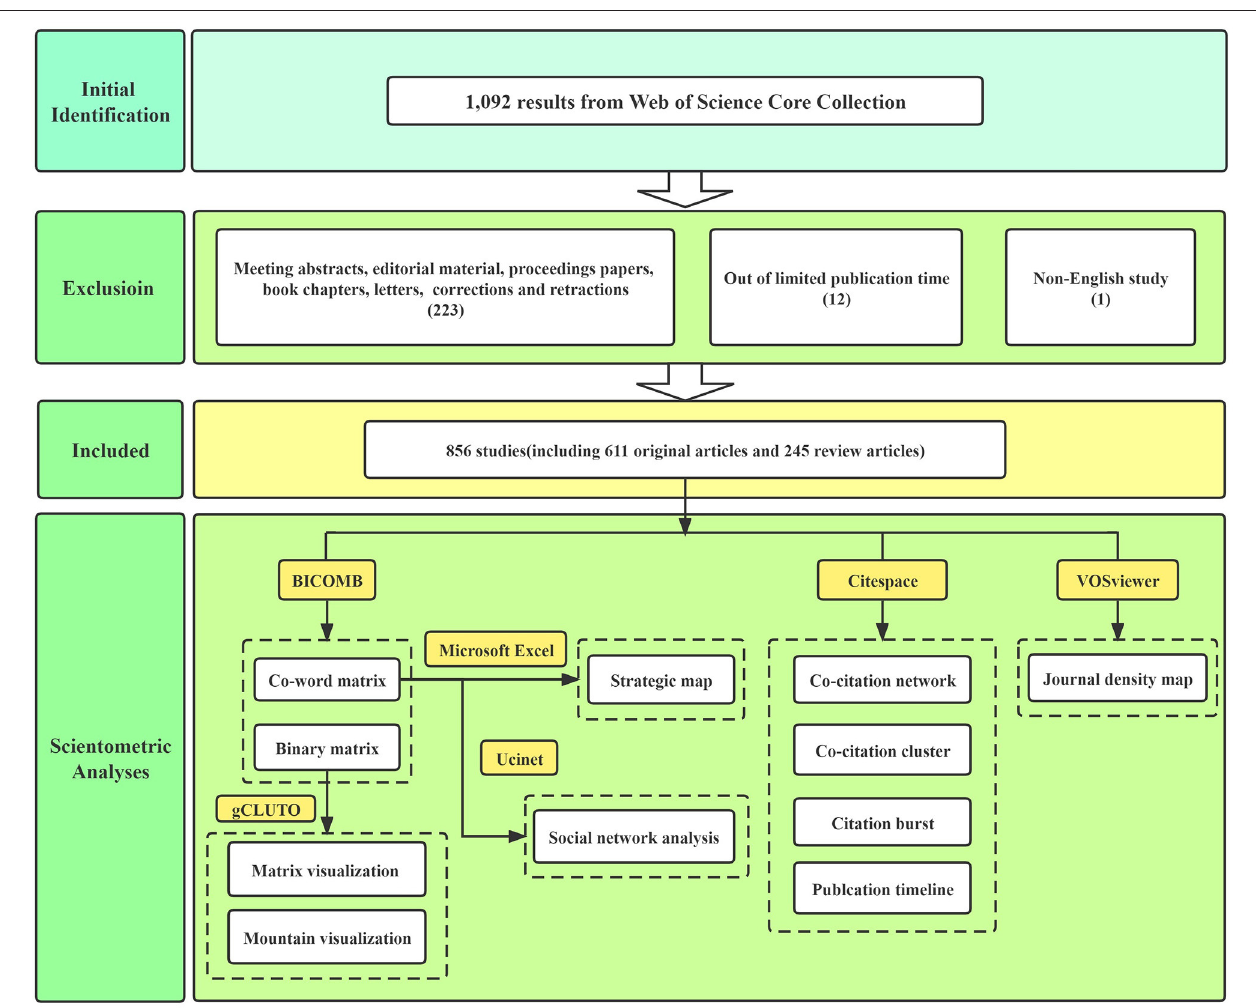
FIGURE 1 | Flow chart of screening processes and scientometric